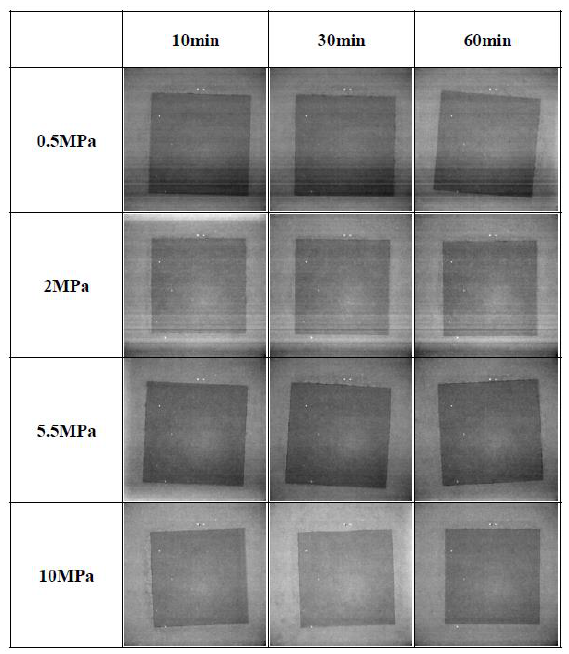
Figure 4. TGA result of the Cu paste.